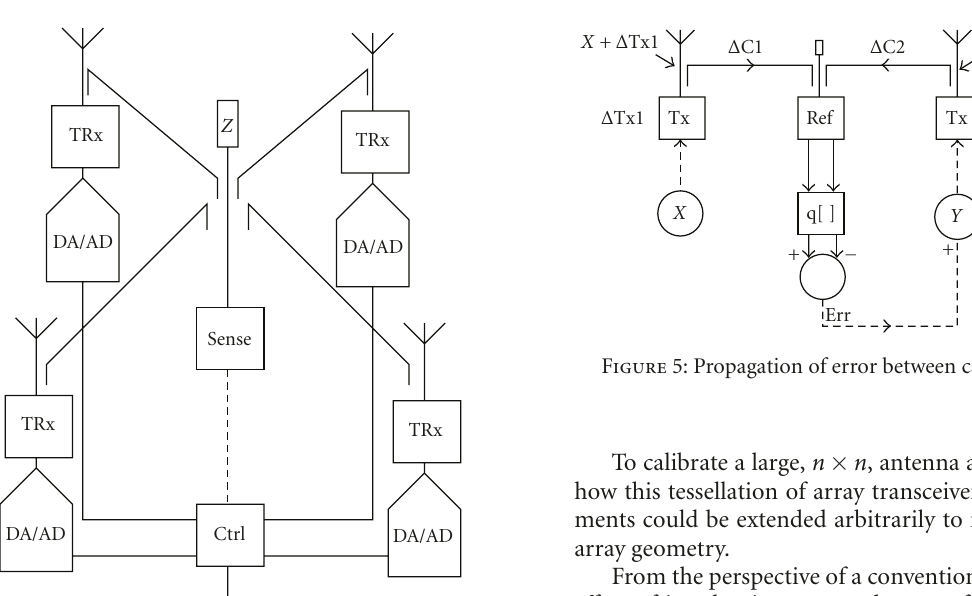
relative phase and amplitude imbalance between the feed points of each of the transceivers is used to create an error signal. This error signal is fed back and used to weight the in- put signal to the transceiver element—e ff ecting calibration.